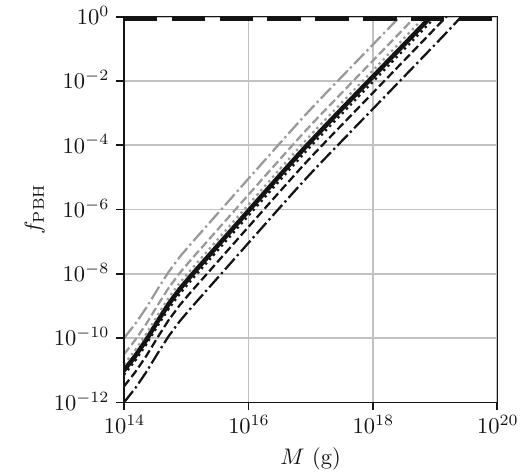
Fig. 5 Modification of the constraint f PBH for T obs = { 1 , 100 } year (dashed grey and black), A eff = { 10 1 , 10 5 } cm 2 (dot-dashed grey and black), (cid:14) = 10% (solid grey, indistinguishable from the fidutial) and (cid:10)(cid:2) = { 2 o × 2 o , 10 o × 10 o } (dotted grey and black) compared to the fidutial set (solid black). “Test” instruments were implemented inside Isatis to obtain these